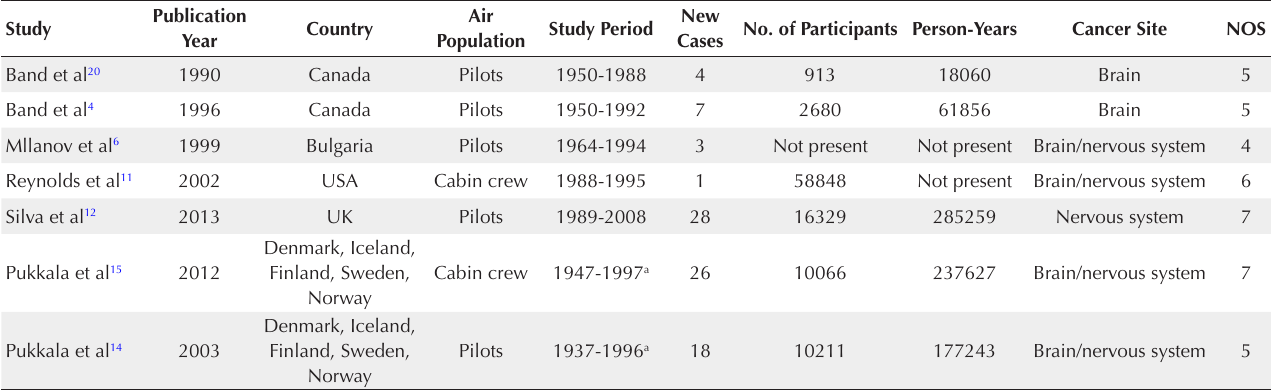
Table 1. Main Characteristics of the Studies Included in This